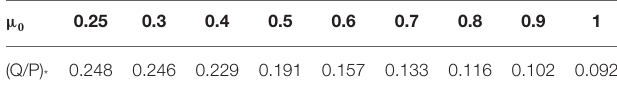
0.5, Q / P 0.3) and (B) sliding contact = =